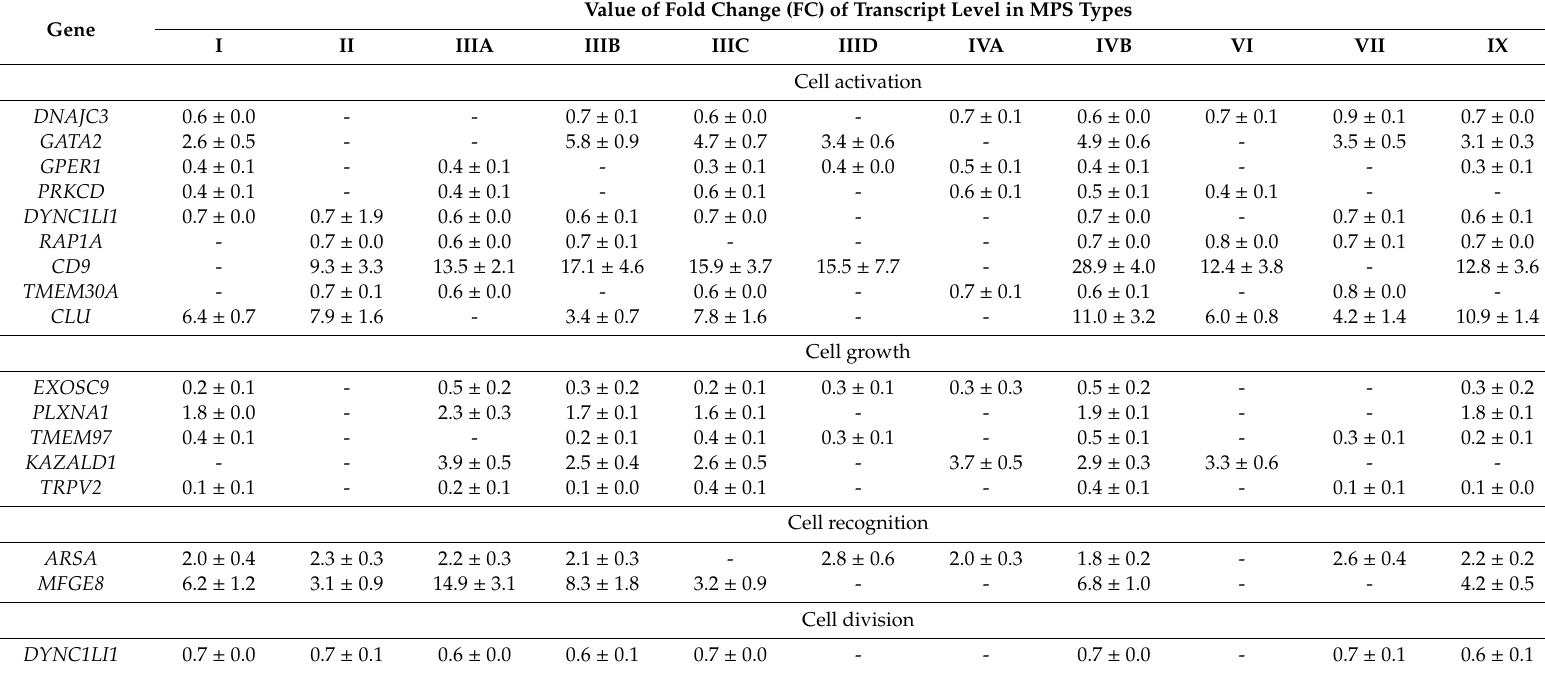
Table 4. Values of fold change (FC) of genes with changed expression levels in at least six types / subtypes of MPS relative to HDFa cells (only in case of a significant